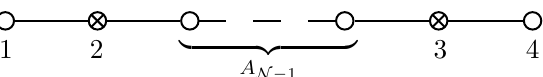
Figure 3 . Dynkin diagram of the Borcherds superalgebra for N -extended supersymmetry. The middle part is the Dynkin diagram of type A N(cid:0) 1 corresponding to the complexi(cid:12)ed su ( N ) R- symmetry. The outer nodes labelled 1 and 4 correspond to A 1 (cid:8) A 1 as before while the two gray nodes correspond to the two spinors.